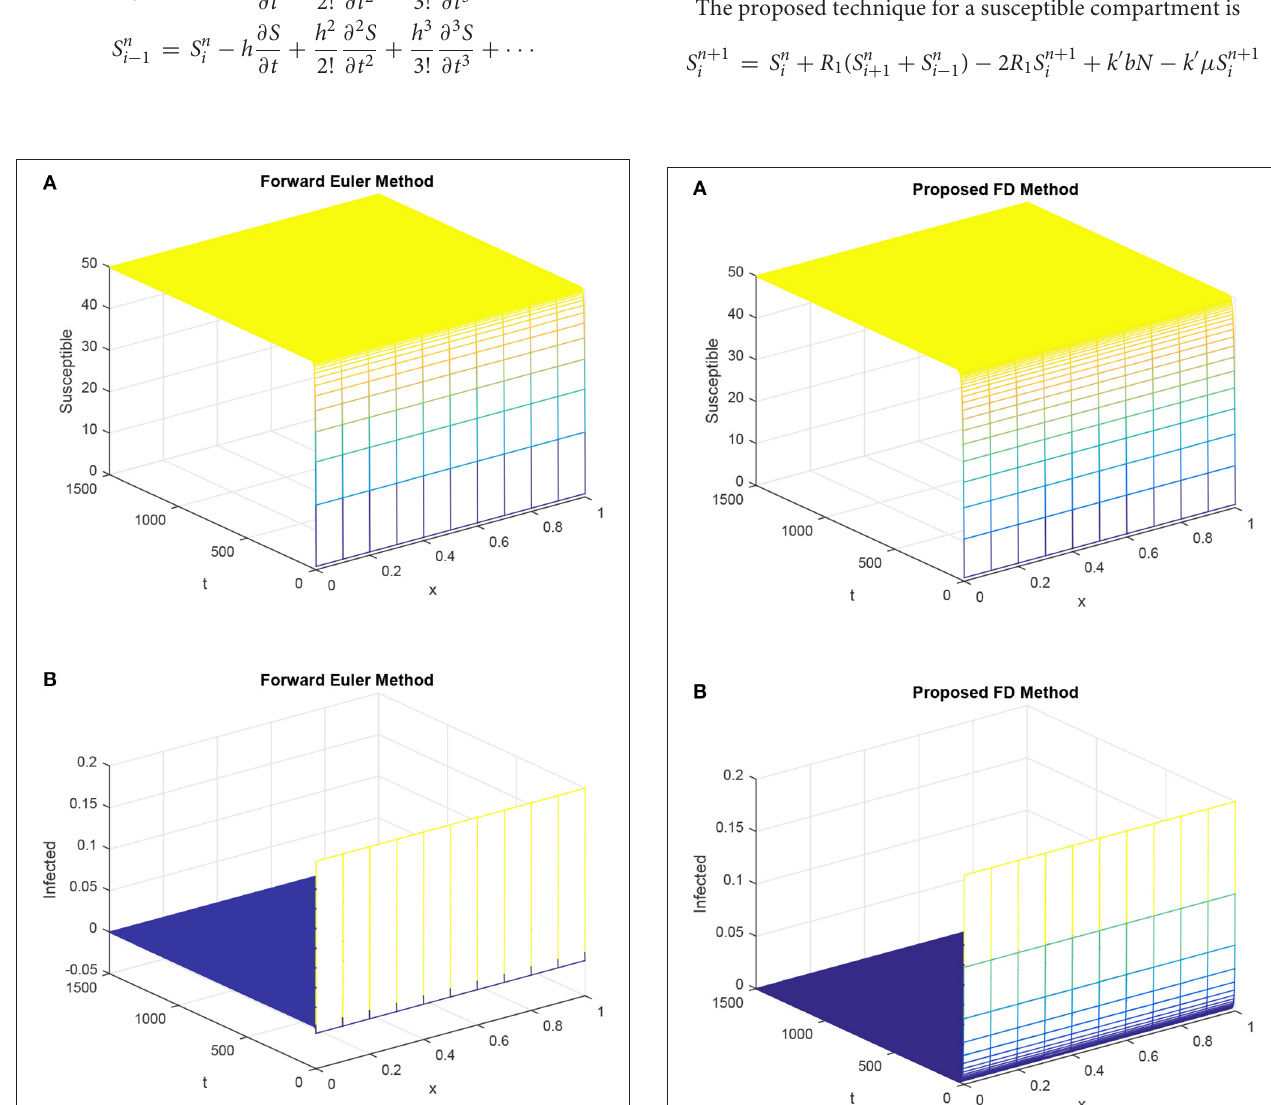
FIGURE 1 | Susceptible population and infected population with the help of Euler method (forward), where dynamics of S and I as shown in (A,B) with h = 0.1 and R 1 = R 2 = 0.15, τ = 1.5. (A) Mesh graph of S . (B) Mesh graph of I .